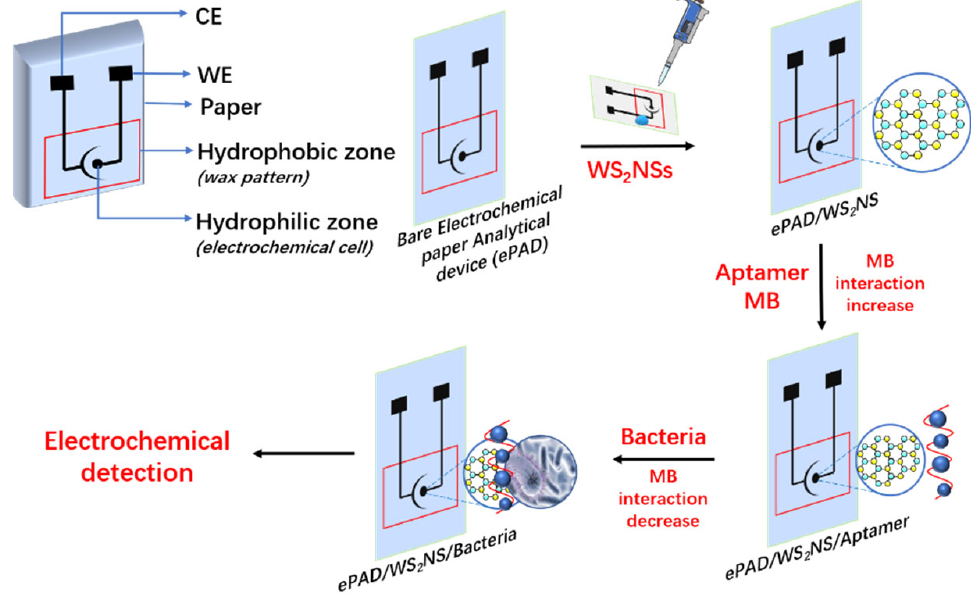
Figure 7. Schematic of a screen-printed paper-based aptamer sensor for the detection of Listeria monocytogenes (Adapted with permission from Ref. [25]. 2022, Mishra et al.).